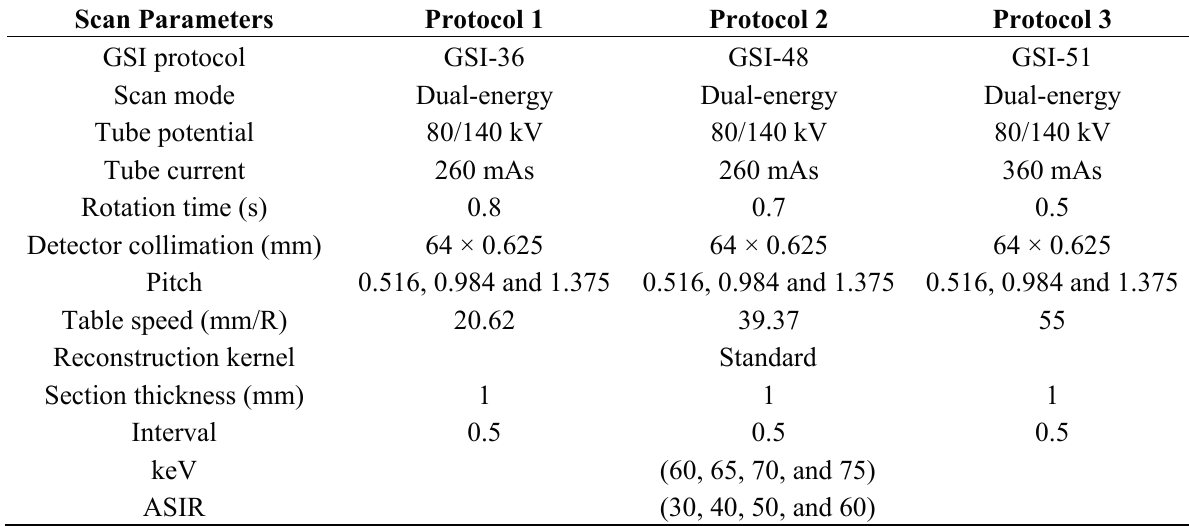
Table 3. Details of scan parameters by